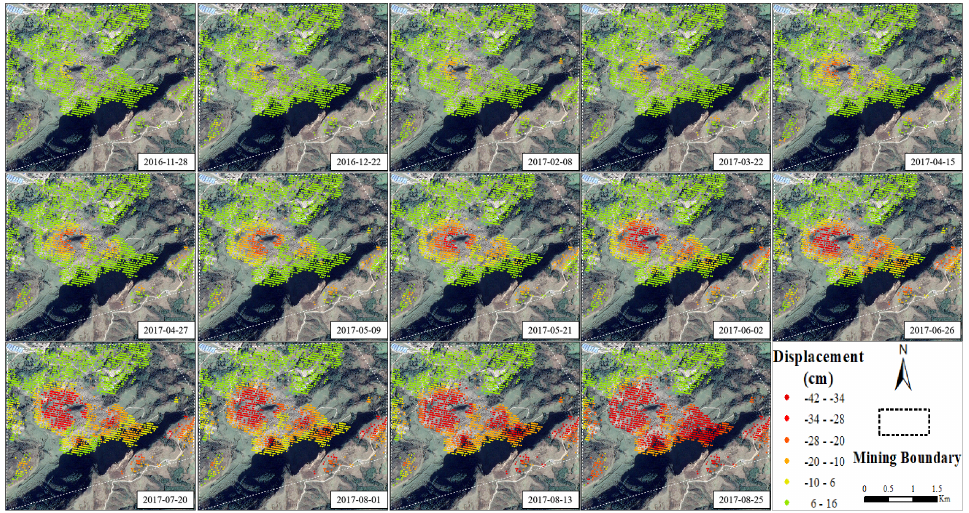
Figure 6. Time series change of mining area displacement in mining